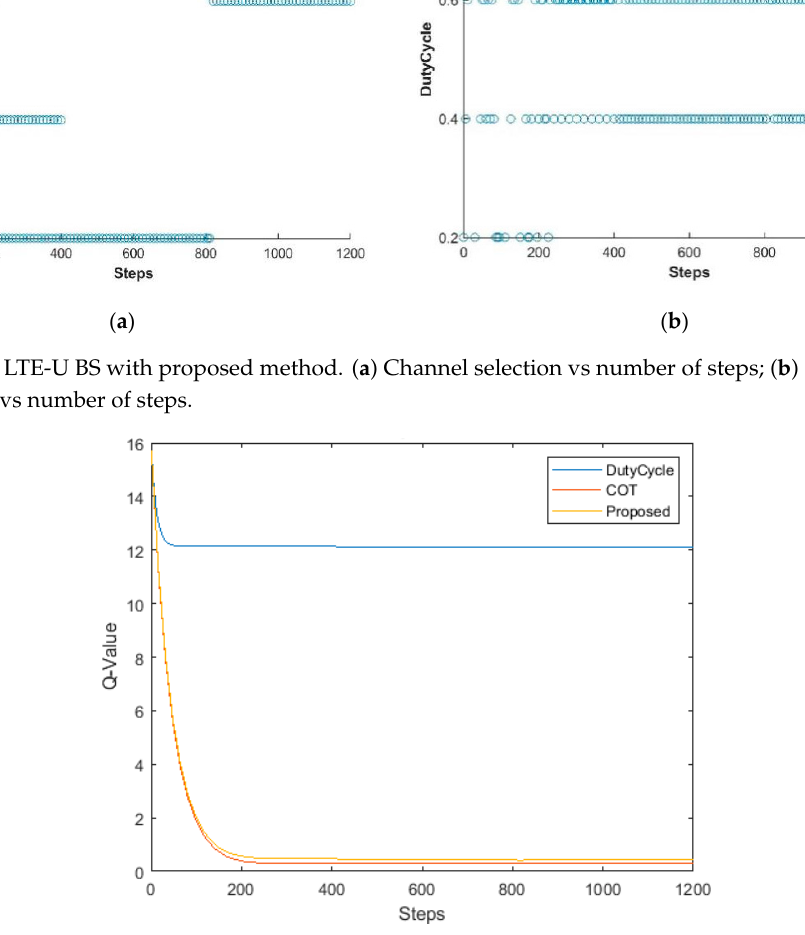
Figure 8. Q-value convergence.